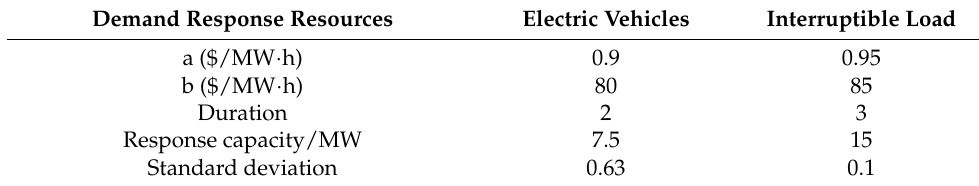
Table 3. Demand response resource